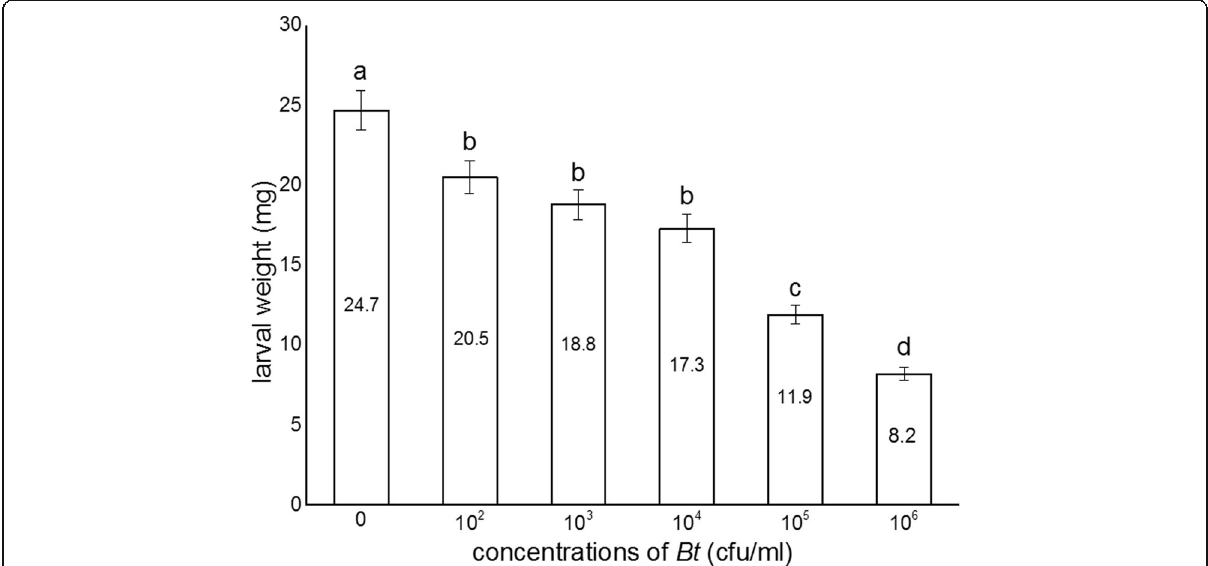
Fig. 2 Effect of Bt CAB109 on body weight of S. exigua